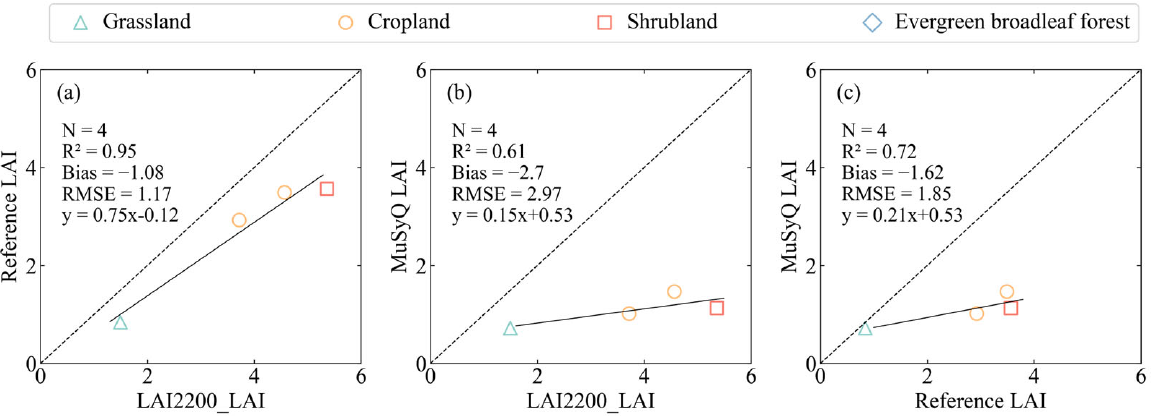
Figure 12. Scatter plots of: ( a ) reference LAI values, ( b ) MuSyQ LAI values versus field measurements with high spatial representativeness, and ( c ) validation results for the MuSyQ LAI products using the reference LAI.